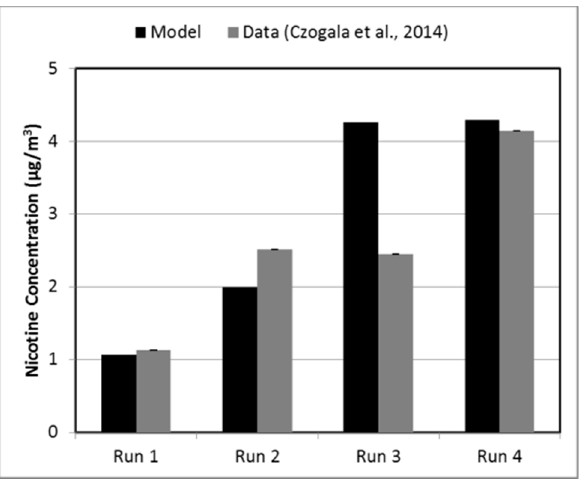
Figure 1. Model prediction and experimental data of average nicotine concentration in the indoor space for smoking machine-generated aerosol source.